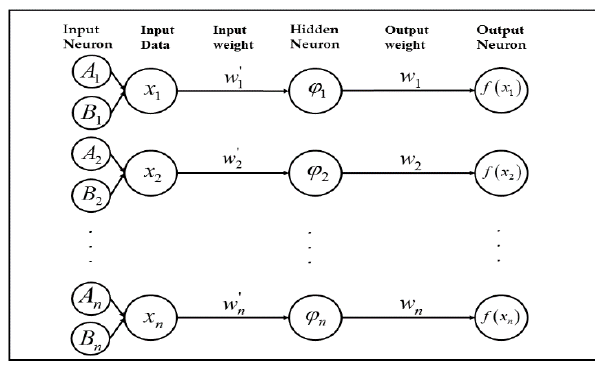
Figure 1. Structure of radial basis function neural network (RBFNN).